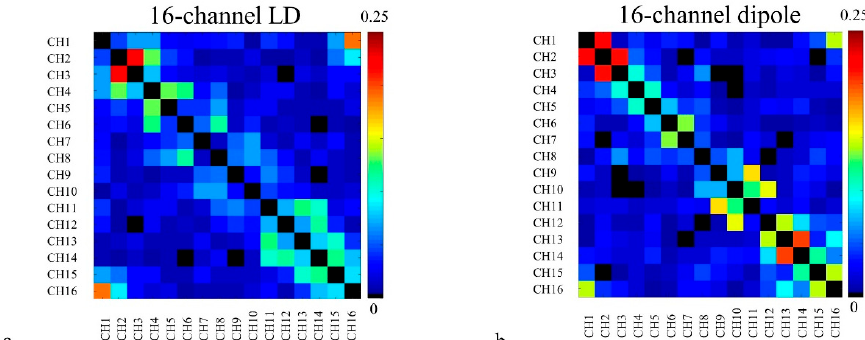
Figure 5. Noise covariance matrices of the 16-channel LD ( a ) and dipole antenna ( b ) arrays. The distance between channels was 8.8 cm for the LD array and 4 cm for the dipole antenna array, respectively.